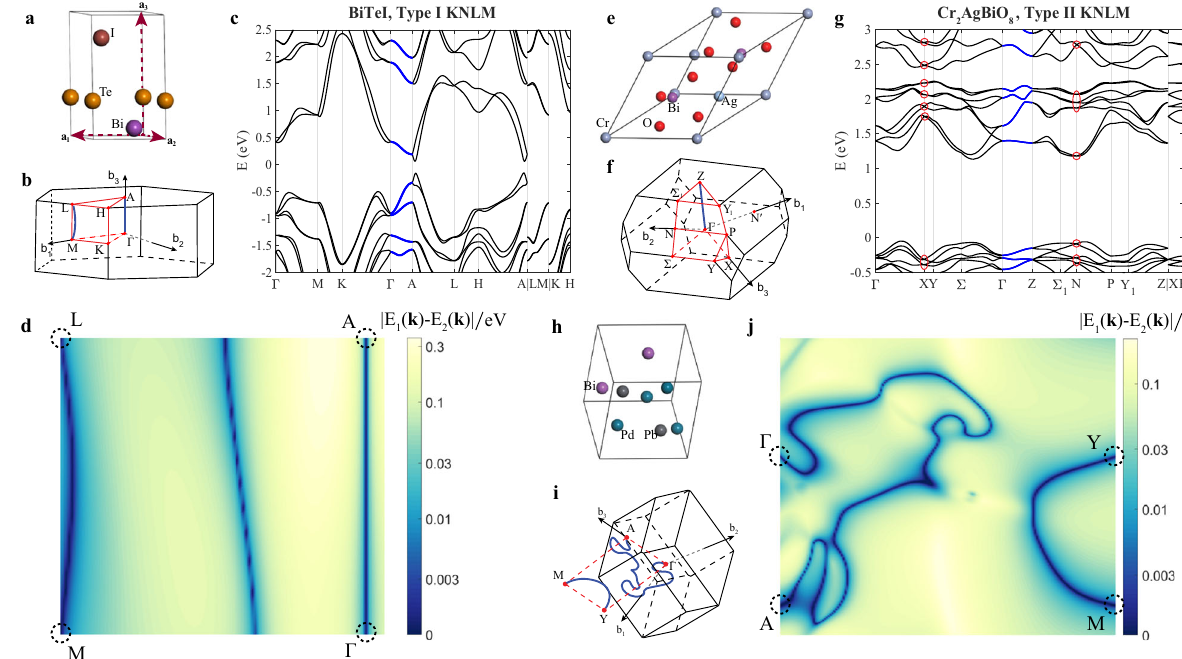
Fig. 2 Representative materials with KNLs. a – j The crystal structure, the fi rst Brillouin zone, and KNLs of BiTeI (SG no. 156, P 3 m 1), Cr 2 AgBiO 8 (SG no. 82, I (cid:2) 4), and BiPd Cm ). c , g The band structures of BiTeI and Cr 2 Pb (SG no. 8, 2 AgBiO 8 , respectively, where the KNLs are highlighted as blue lines, and the crossing points within the red circles of f are KW points. These KNLs are also marked out by solid blue lines in the 3D fi rst Brillouin zone. d , j The DFT- calculated energy difference of two selected SOC-split bands ∣ E 1 ( k ) − E 2 ( k ) ∣ (in units of eV) on a mirror-invariant k plane for BiTeI and BiPd 2 Pb, respectively. The dark green lines that connect two TRIMs (dashed circles) are KNLs on this mirror